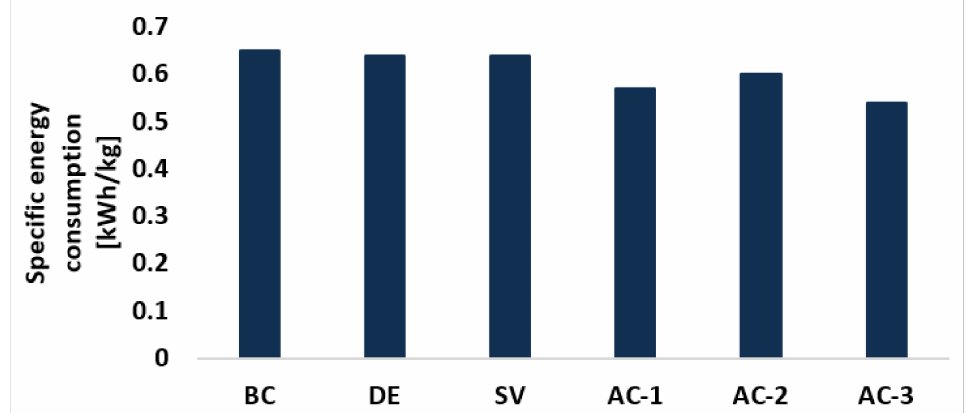
Figure 8. Specific consumption results for the several